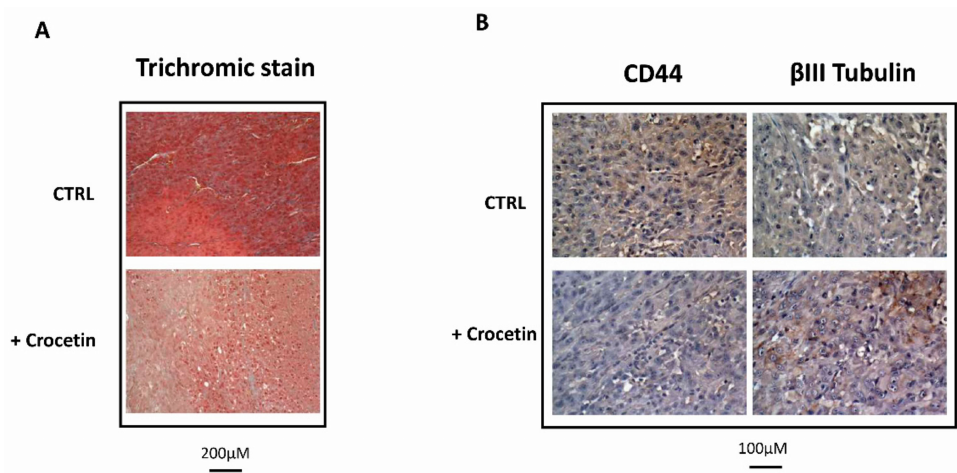
Figure 5. Histological and immunohistological analyses performed in tumors that were grown in the presence of a vehicle or CCT. ( A ) Trichromic staining performed at 20 × magnification (bar represents 200 µ m) and ( B ) CD44 and β III tubulin expression on images harvested at 40 × magnification. Bar represents 100 µ m.